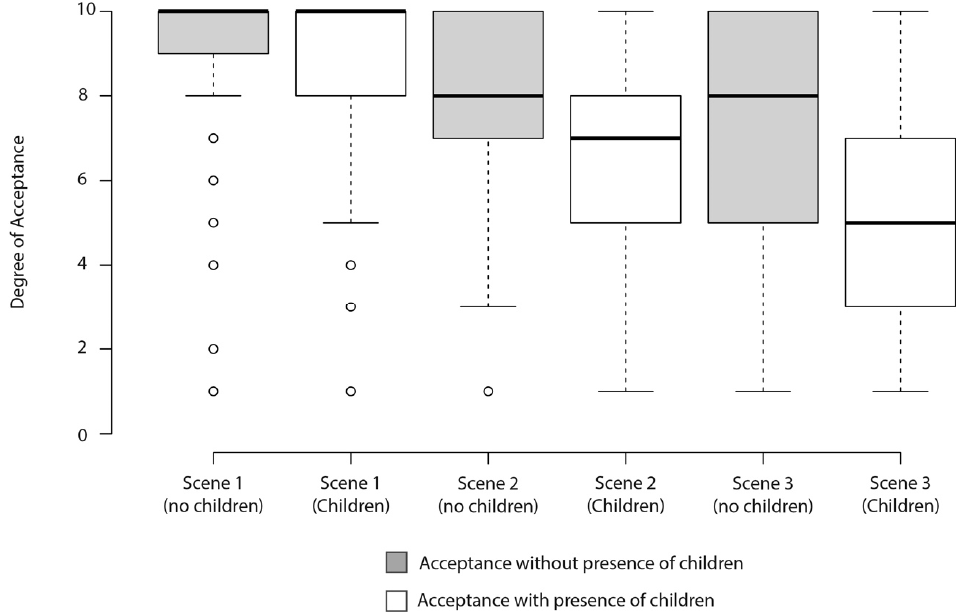
Figure 9. Median scores for level of acceptability in each scenario, with and without children. Scene 1: null alcohol exposure; Scene 2: medium alcohol exposure; Scene 3: high alcohol exposure p -value assessed with Kruskal – Wallis.